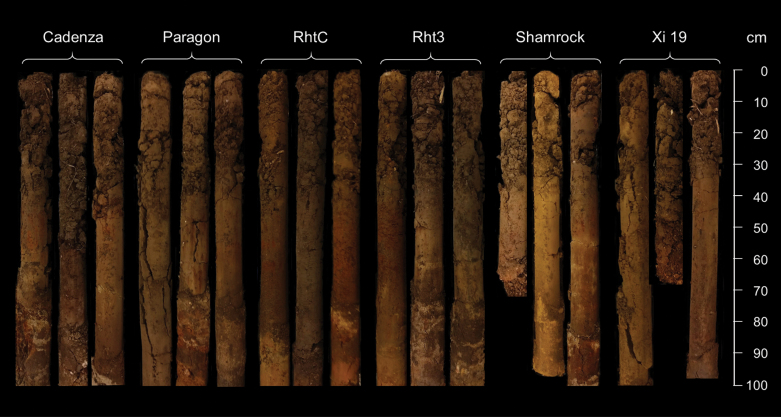
Illustration of the 18 soil cores (six wheat genotypes, three replicates, 9 cm in diameter) taken from the field experiment.